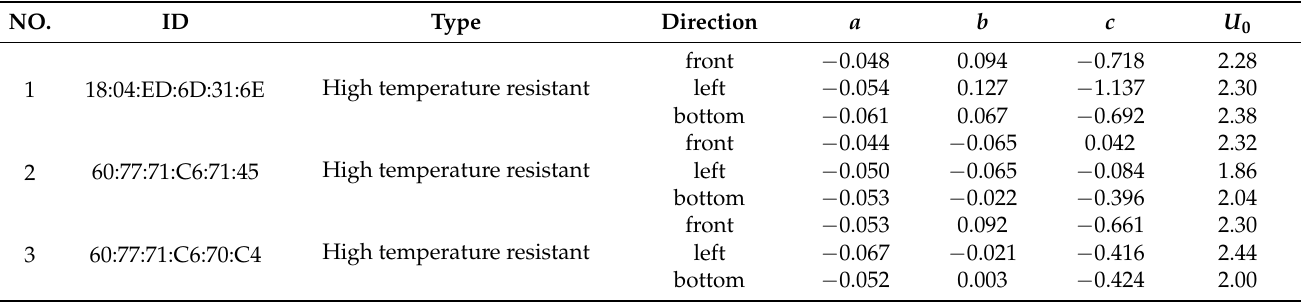
Table 5. Temperature–stress calibration coefficients.